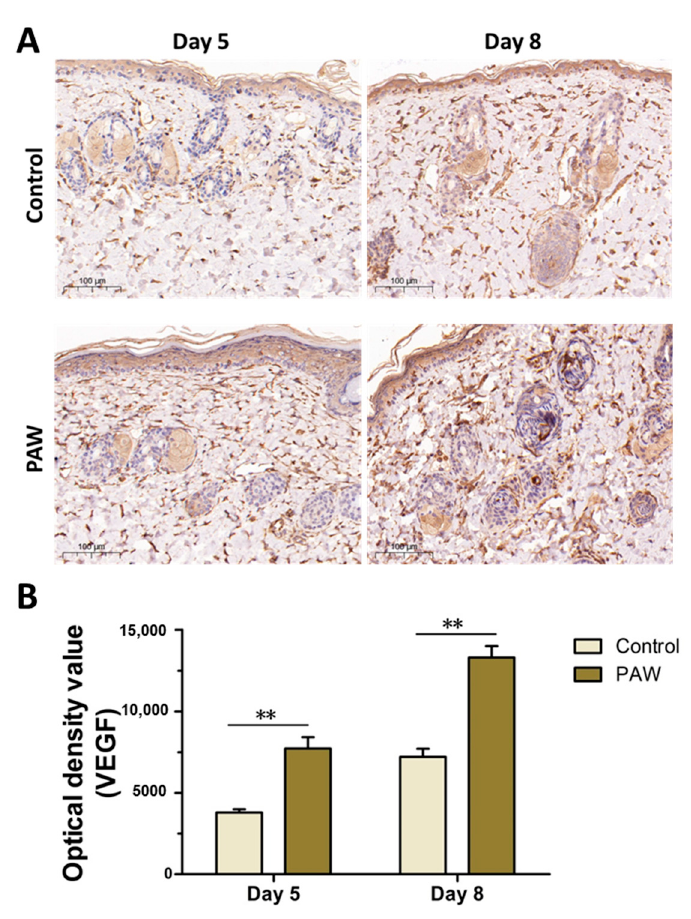
Figure 5. Expression level of vascular endothelial growth factor (VEGF). ( A ) Comparison of the expression levels of VEGF in the wounded skin on days 5 and 8 between the control and PAW treatment groups. ( B ) Quantitative statistical results of the positive expression of VEGF. Data are expressed as the mean ± SD; ** p < 0.01 (Student’s t -test).